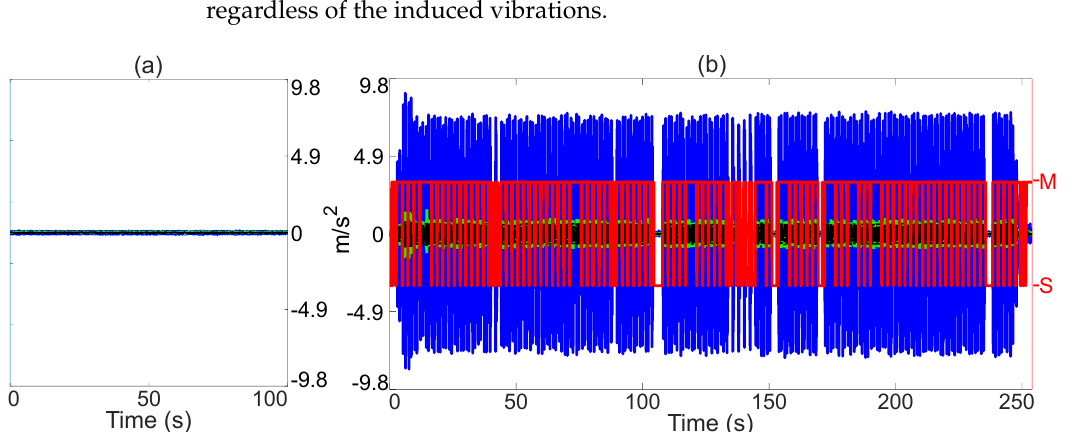
Figure 9. Shown are the vehicle accelerations along the z LCP (blue), y LCP (green) and x LCP (black) axes. ( a ) Shows the vehicle accelerations of the RF training dataset with the label “Standstill”. ( b ) Shows the vehicle accelerations while the music is playing and the RF output (red, S = standstill, M = motion). Vehicle: 2nd Gen. Audi Q7. Motorization: 6 cylinder, 3.0 L TFSI. Power source: Gasoline.